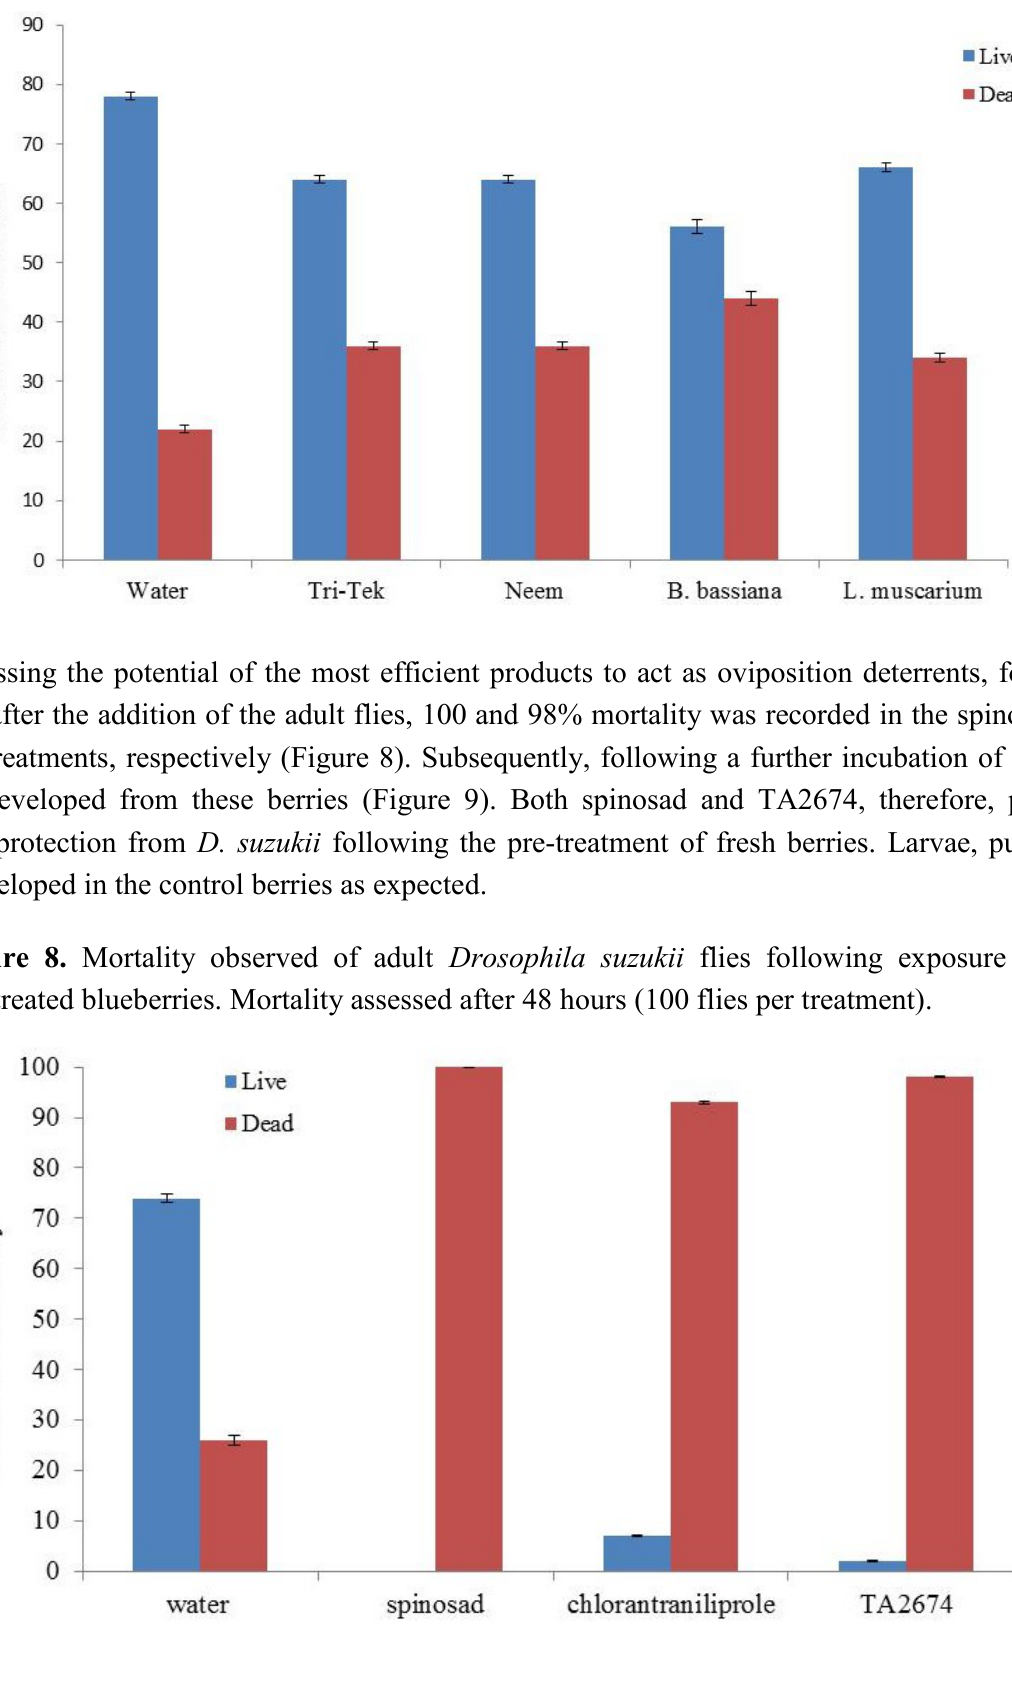
Figure 7. Impact of direct application of alternative products and entomopathogenic fungi against adult Drosophila suzukii . Mortality assessed after 7 days (50 flies per treatment).